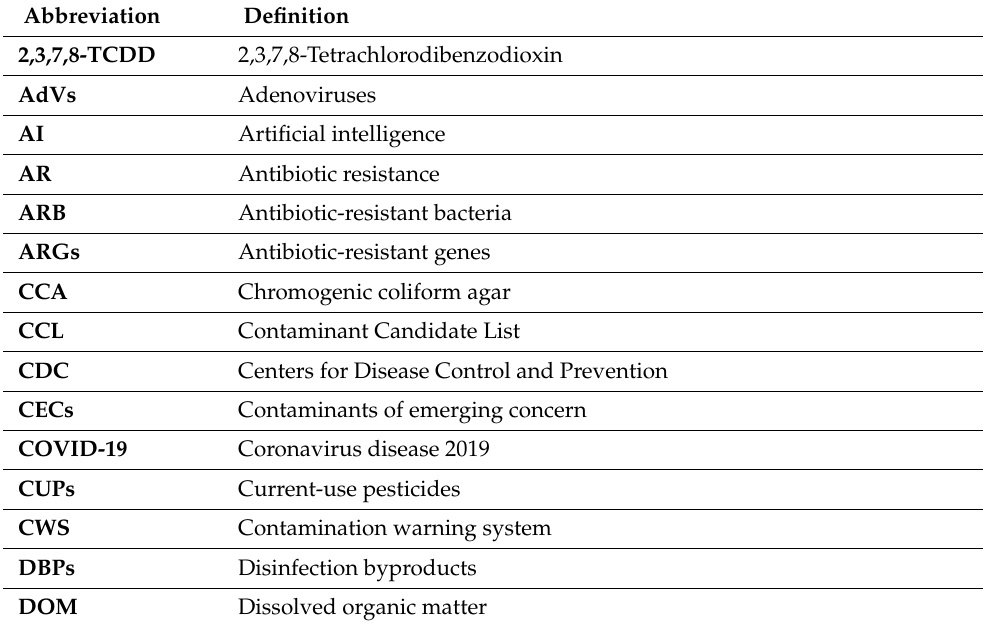
Table A2. Definition of